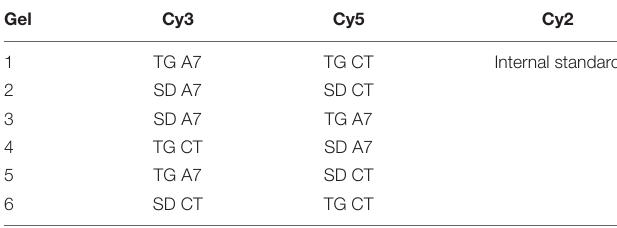
TABLE 1 | DIGE experimental